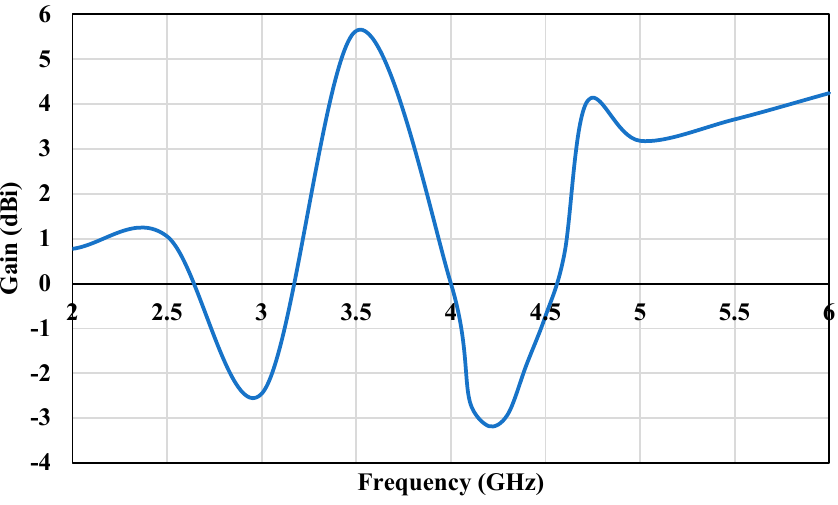
Figure 12. Gains of the proposed antenna in the frequency range of 2 − 6 GHz. Table 3. Comparative study of the proposed antenna with the existing designs.